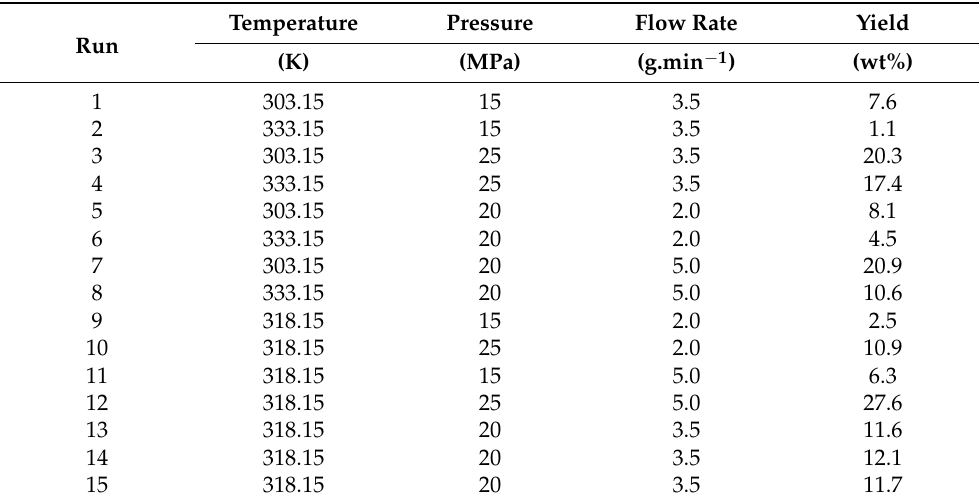
Table 1. Experimental conditions and extraction yield results for pequi oil extraction using supercriti- cal CO 2